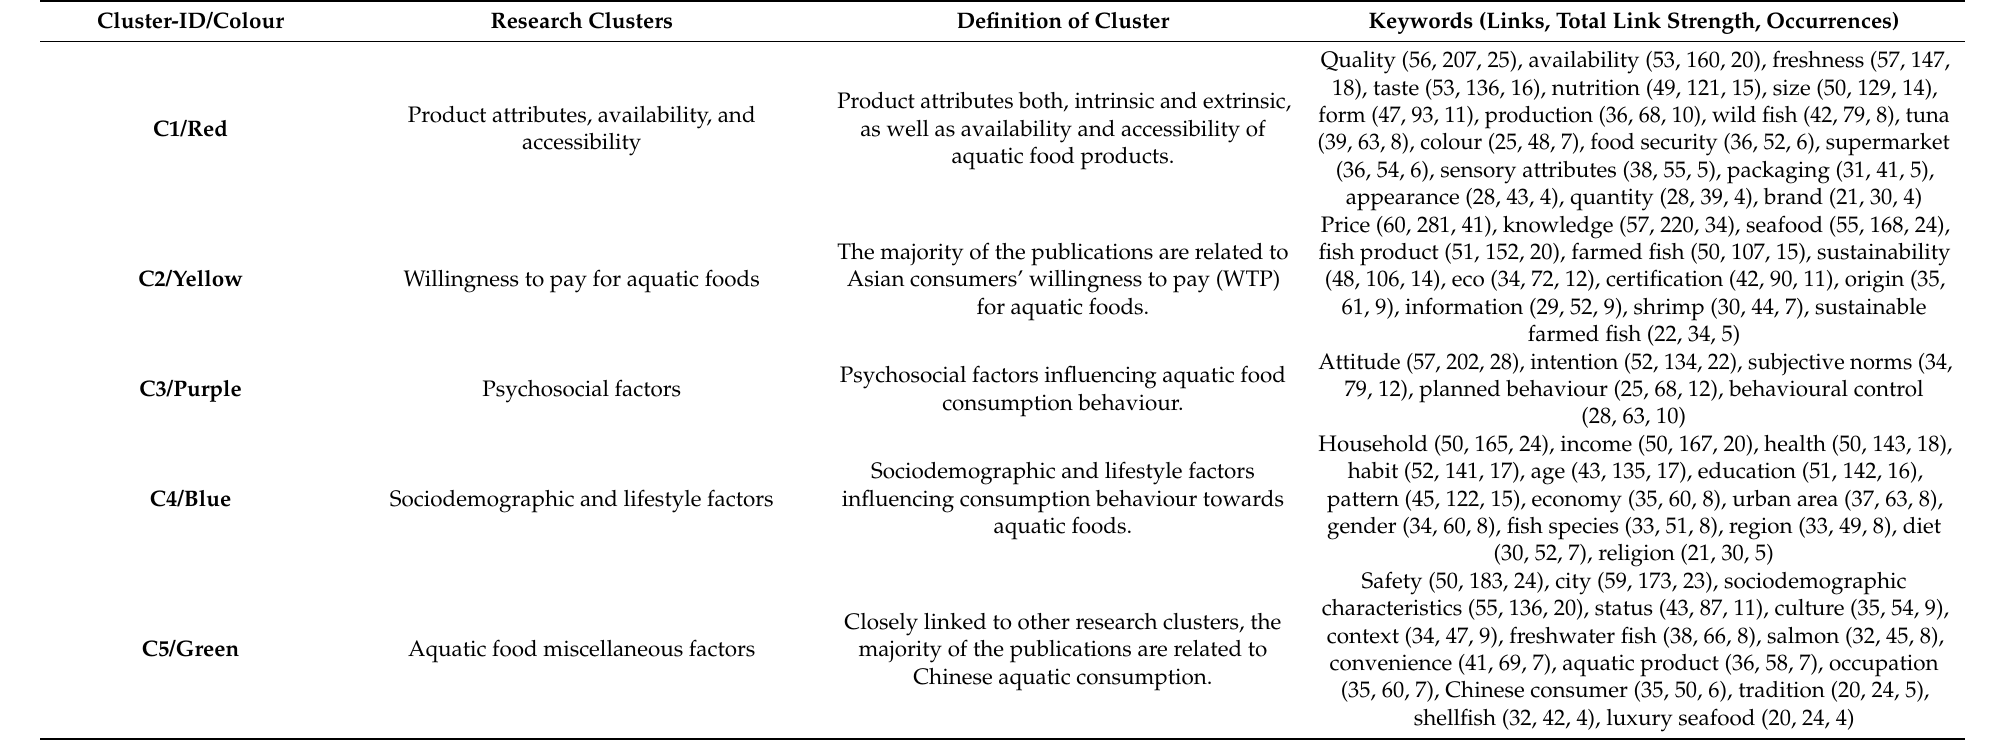
Table 1. Defining research clusters based on keywords used in aquatic food consumption